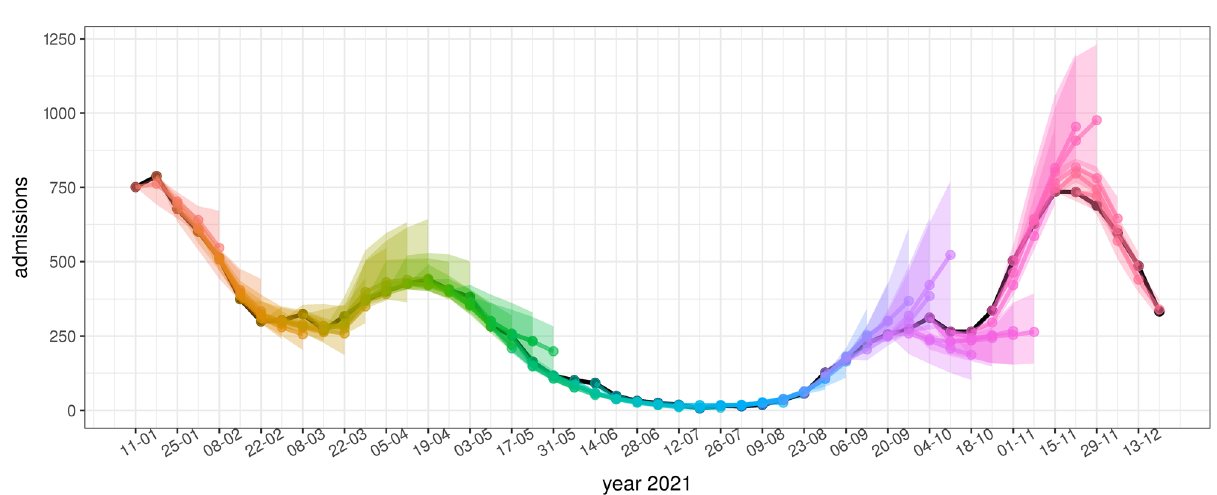
Figure 5. Model forecasts of weekly incidence of COVID-19 hospital admissions. The representation is the same as in Fig.